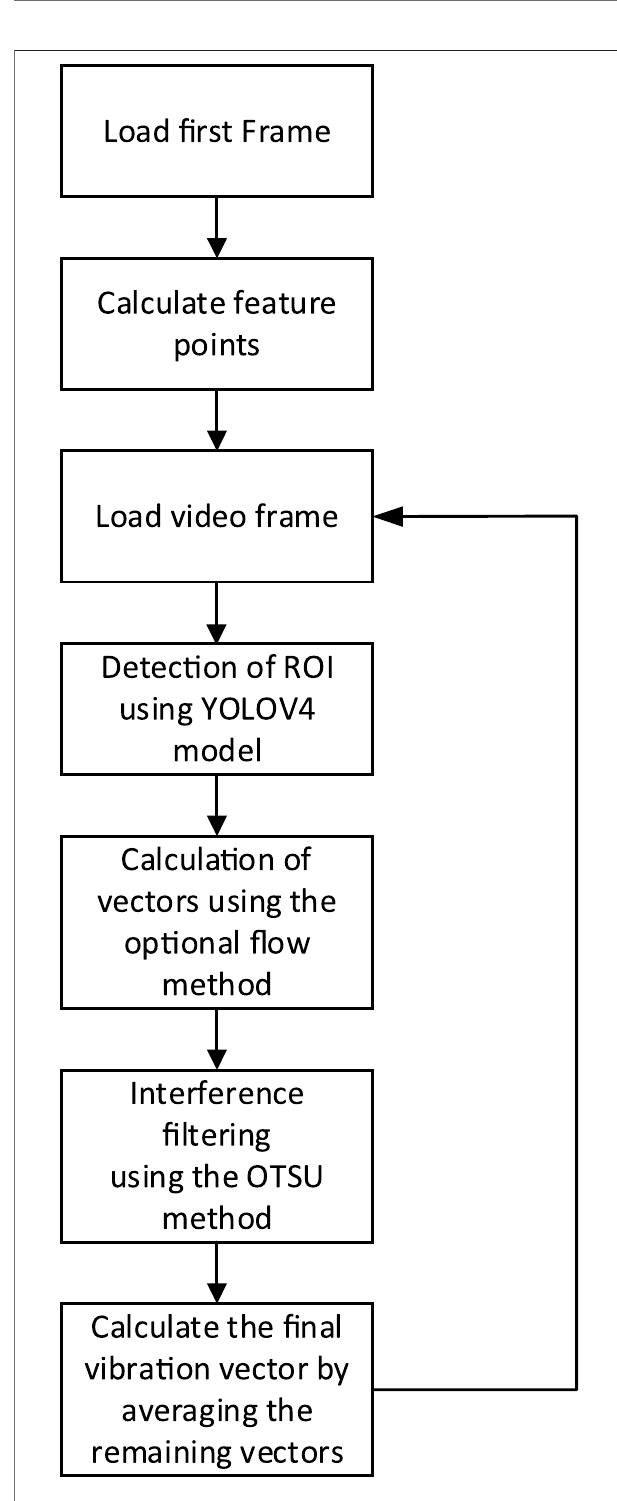
FIGURE 5 | Flow chart of the proposed